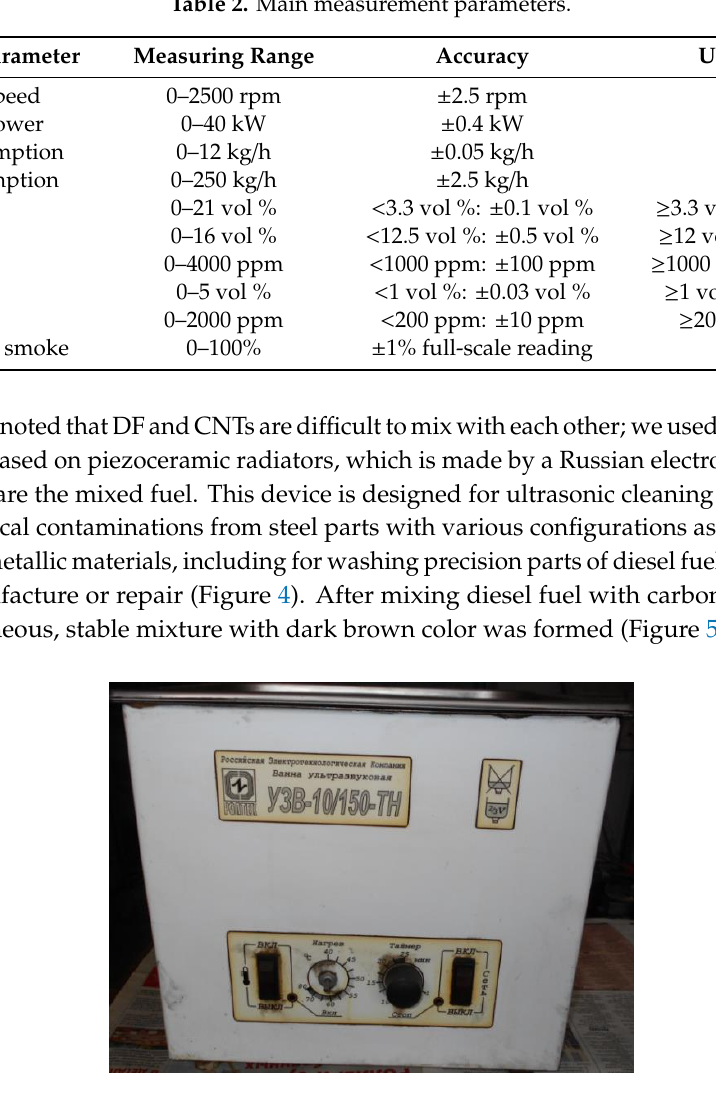
Figure 4. Ultrasonic bath used for preparing mixtures of petroleum diesel fuel with carbon nanotubes (CNTs).